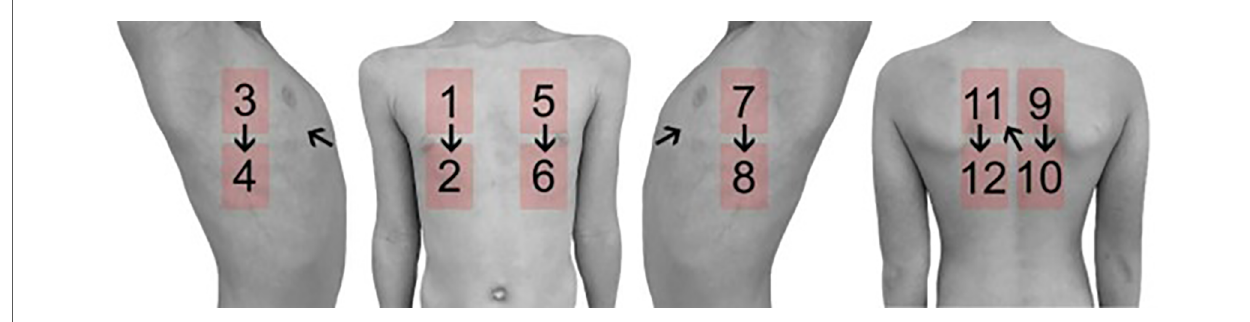
FIGURE 1 Schematic illustration of the examined localization in lung ultrasound.